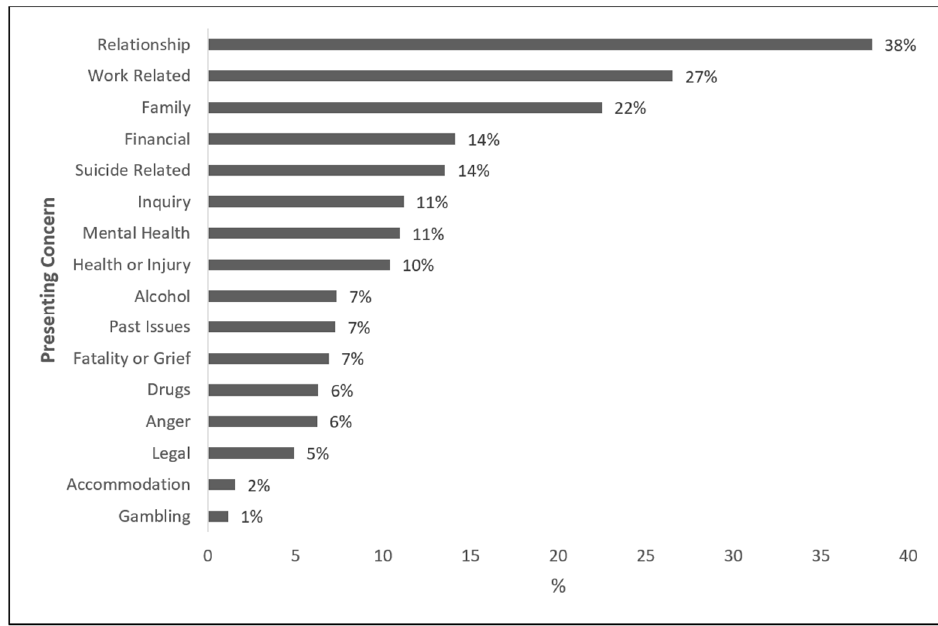
Figure 3. Distribution of presenting concerns within the MATES case management database.